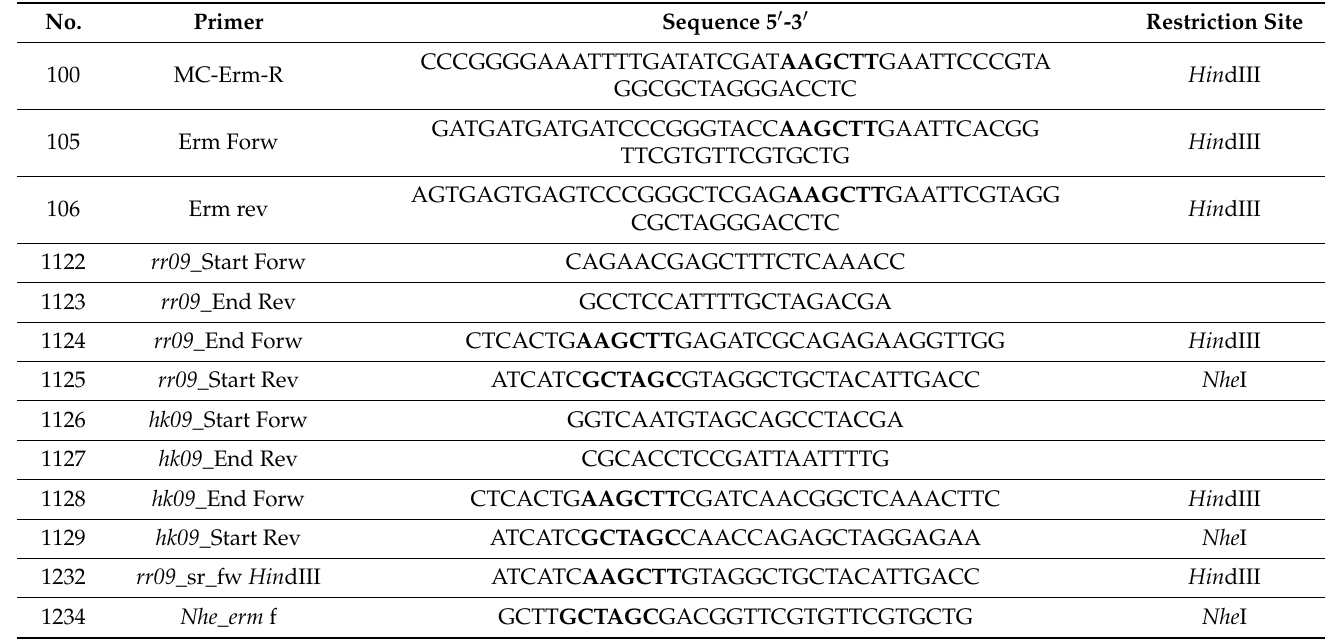
Table 2. Primers used for mutagenesis.